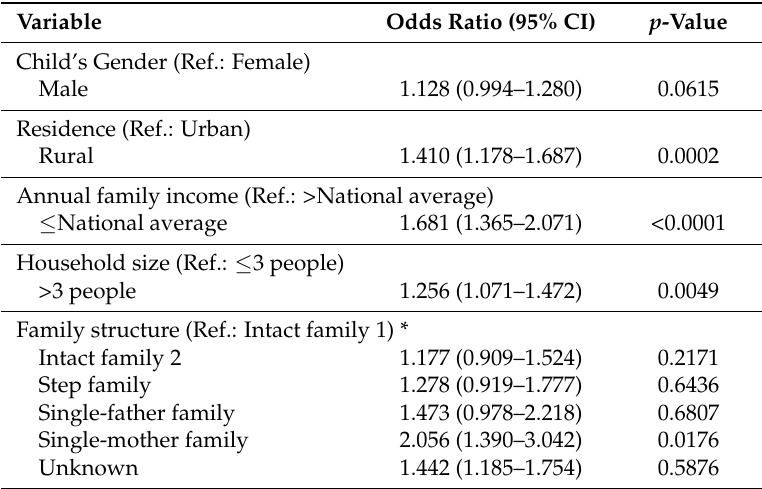
Table 5. Family structure on the risk of hearing impairment among Chinese children (hearing impairment vs. healthy children).